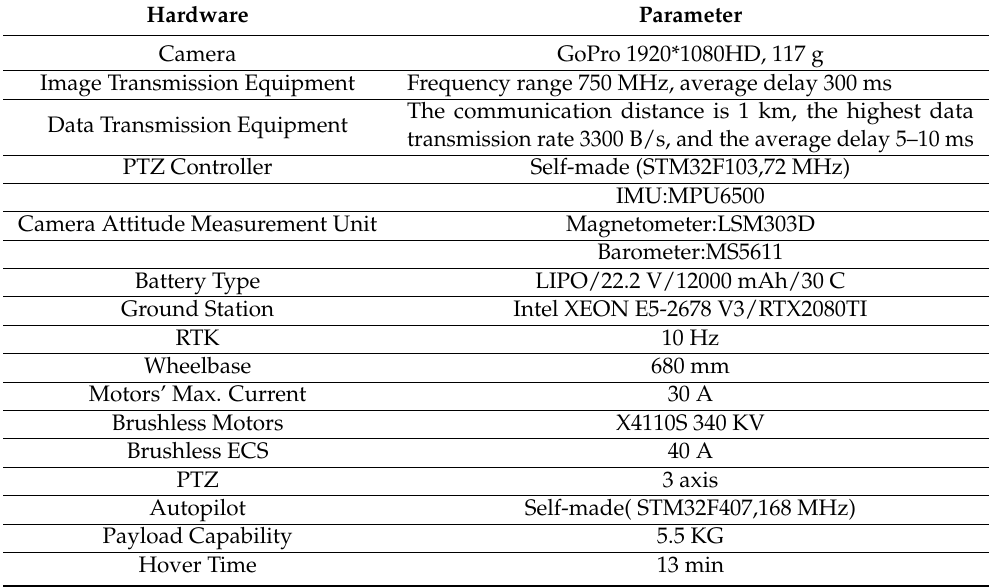
Table 1. Experimental platform models and